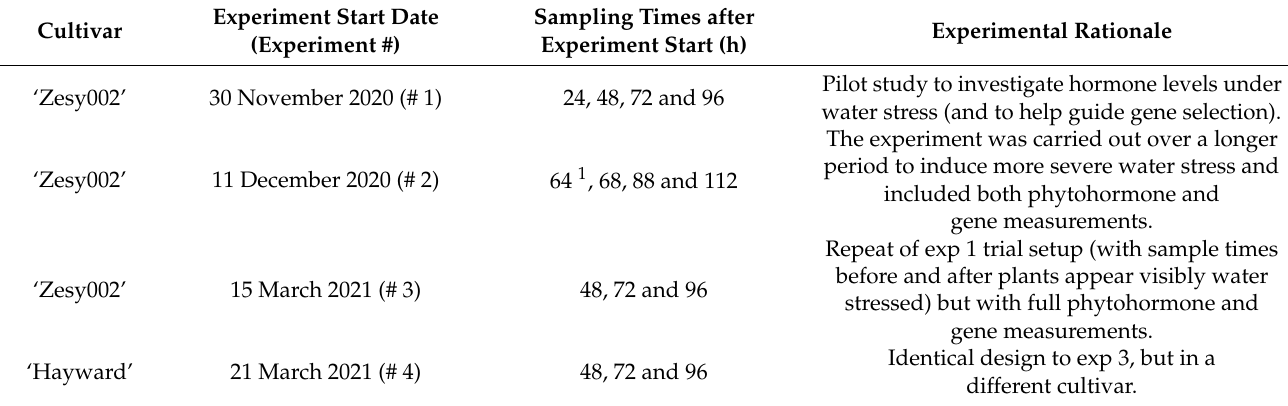
Table 2. Sampling times and rationale for the four water stress experiments conducted on